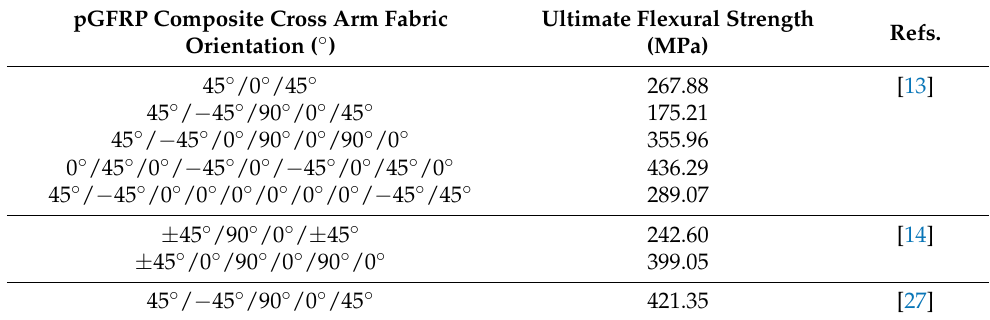
Table 3. Fibre orientation and thickness of pGFRP composite cross arms in previous studies [2].